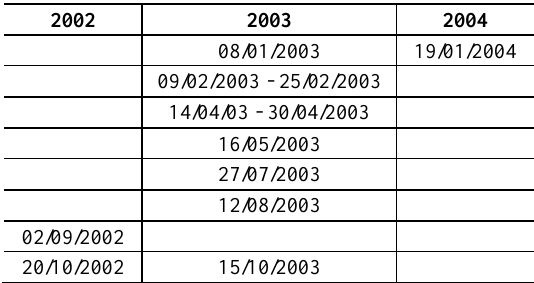
Table 1: Acquisition dates of the images in the dataset.